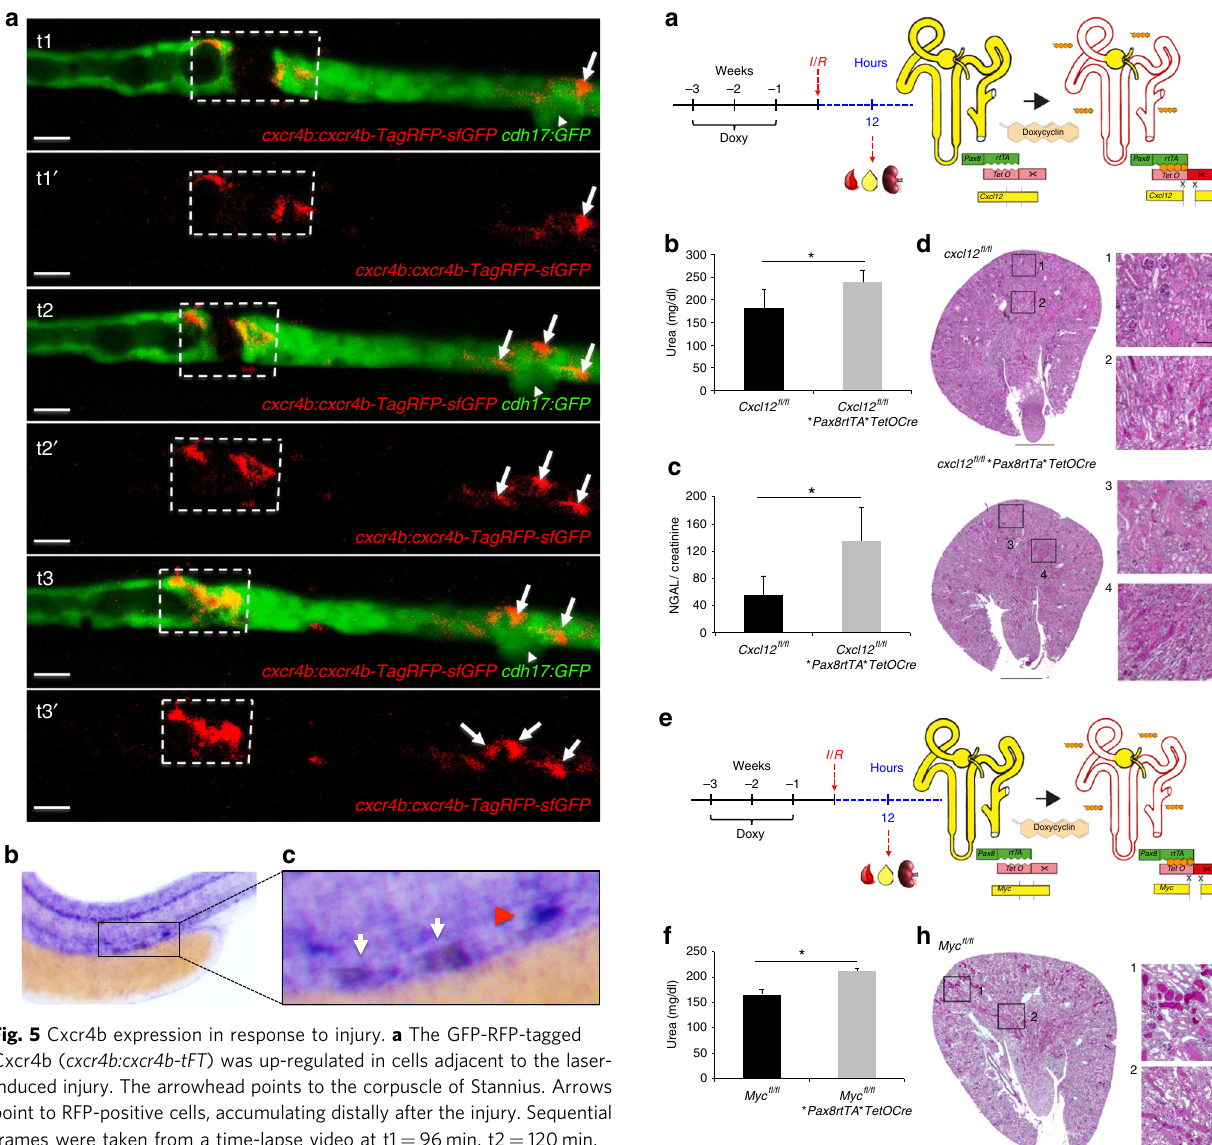
regulated Gene Ontology (GO) terms, using Gene Set Enrichment analysis (GSEA) (Supplementary Fig. 19). GO term enrichment analysis also revealed signi fi cant changes in retinoic acid metabolic processes for the Cxcl12 KO ( q = 6.8 × 10 − 6 ) and for the Myc KO ( q = 0.006) kidneys exposed to I/R injury (Fig. 7a). Retinoic acid can induce Cxcr4 , enhance mitochondrial func- tion 30 , and augment energy metabolism 31 , providing a potential approach to reverse the observed defects. We therefore tested whether retinoic acid can ameliorate the recovery after I/R injury.